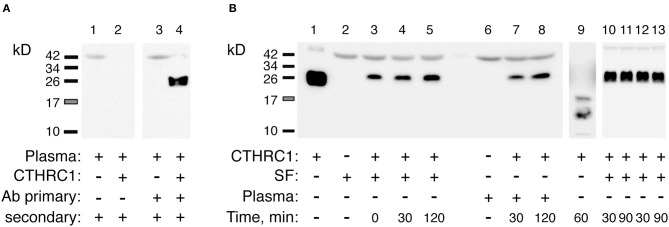
Detection and stability of plasma CTHRC1. (A) The specificity of the immunodetection was tested using 25 ng rhCTHRC1 spiked into the plasma (3 μL) of RA patients. Protein ladder bands (kD) are shown. (B) The resistance of the protein to proteolysis was tested with rhCTHRC1 spiked into synovial fluid (SF) or the plasma of RA patients. Final concentration of SF or plasma in the test was 12%, final amount of rhCTHRC1 loaded per lane was 15 ng. Lane 1 shows 50 ng of recombinant rhCTHRC1 protein as a reference. The Vli55 antibody was used for CTHRC1 immunodetection followed by appropriate secondary antibodies. As a positive control for digestion, incubation with trypsin was performed (lane 9). Lanes 10, 11: SF was heated for 30 min at 65°C (time, min) and then incubated with rhCTHRC1. Lanes 12, 13: SF was pre-heated for 30 min at 37°C.